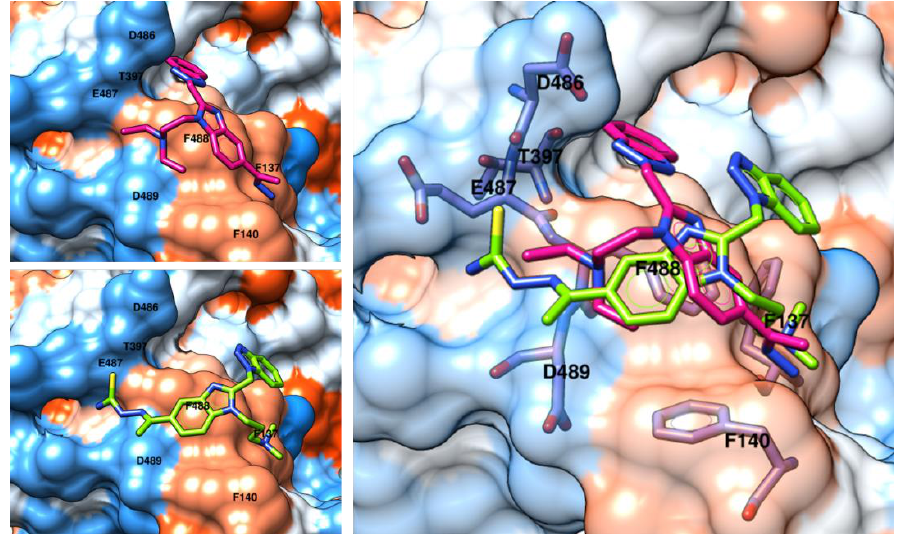
Figure 6. X-ray crystallographic data of the RSV F protein (pdb code: 5KWW; C atom; purple). Docking positioning of the inhibitors 22 and 25 (C atom; green and deep magenta, respectively) are shown within the surface of the protein (left side). Superimposition of the docking poses of 22 and 25 are shown on the right side. The most important residues are labelled and colored by atom type.